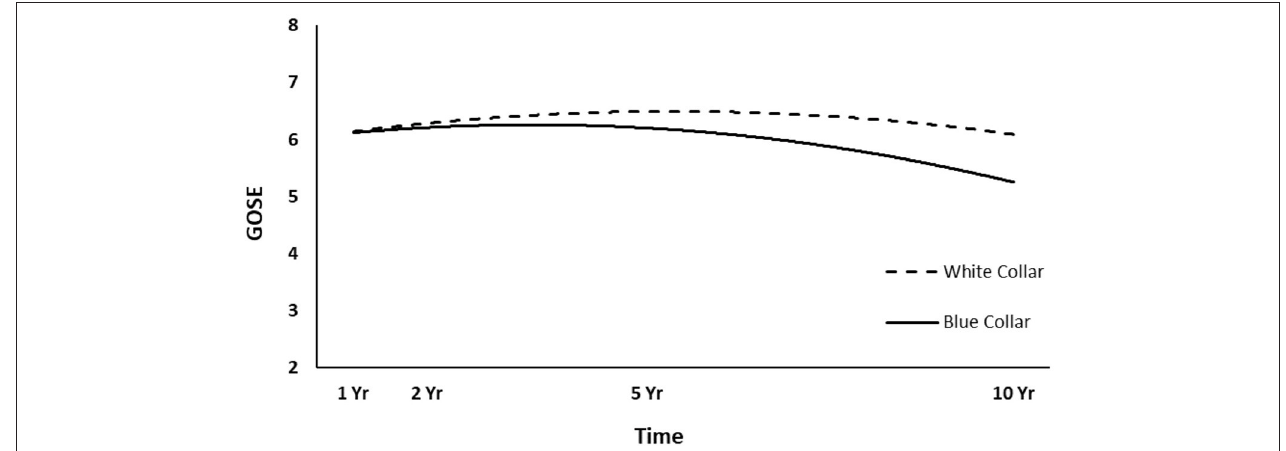
FIGURE 5 | Main effect and quadratic time interaction effect of occupation type on GOSE trajectories.